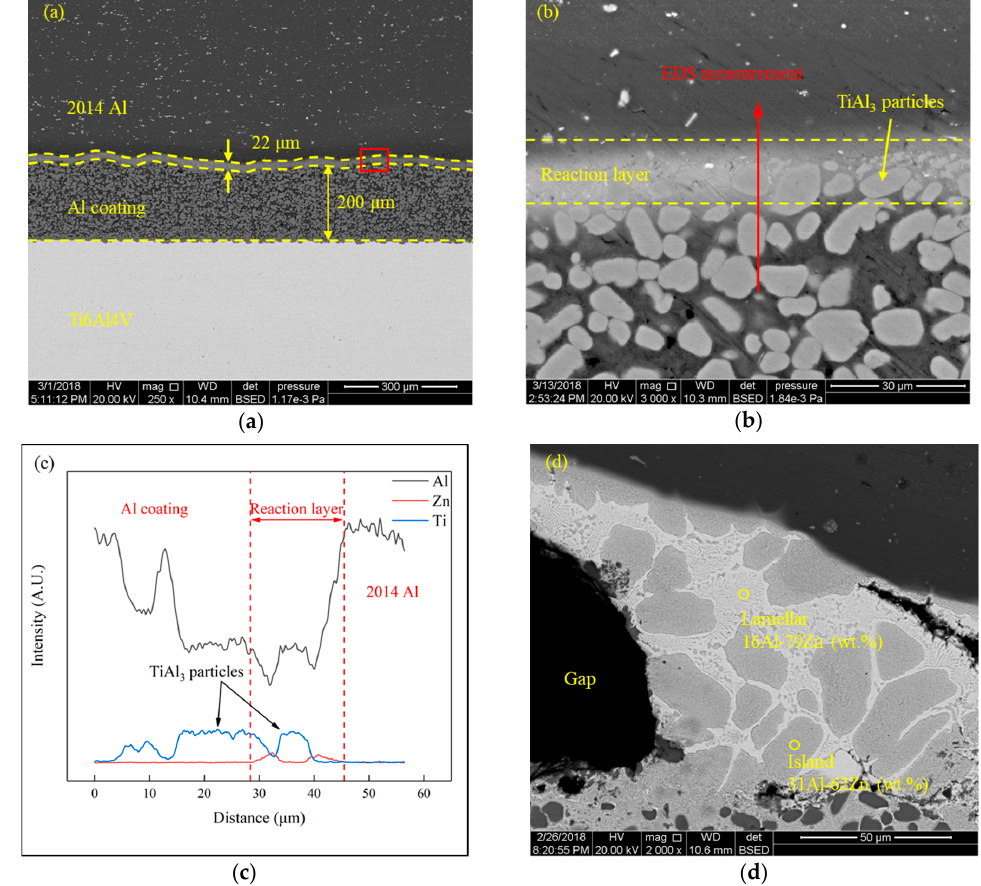
Figure 6. Microstructure of the brazing zone of the joint with ( a ) low magnification (region B marked in Figure 3a) and ( b ) high magnification (red square marked in ( a )); ( c ) EDS results across the reaction layer (red line marked in ( b )); ( d ) microstructure of the region at the end of the brazing zone (region C marked in Figure 3a), showing the Al–Zn eutectic structure. The thickness of the reaction layer was based on the measured distribution of Zn element.